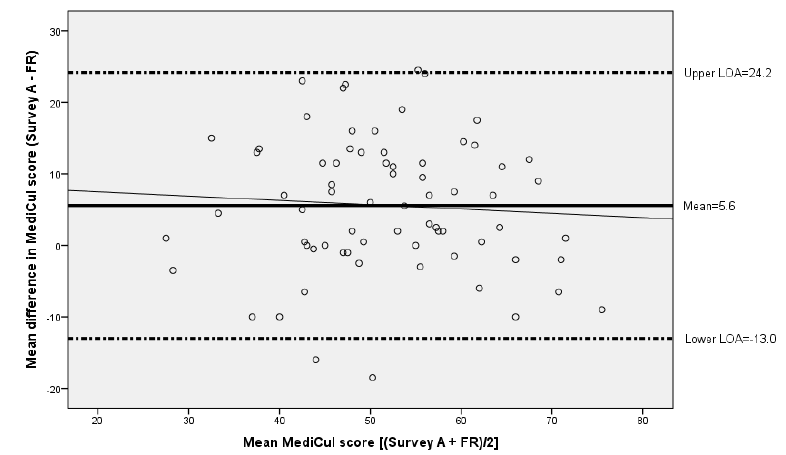
Figure 3. Bland-Altman plot of the difference in the Mediterranean Diet and Culinary Index (MediCul) score between survey A (first administration of MediCul tool) and three-day FR versus the mean MediCul score of the two methods ( n = 71). The solid line indicates the mean difference, whereas the dotted lines are the limits of agreement representing ± 2 SD from the mean difference within which 95% of the differences between the methods are expected to fall. The fitted regression line is ((y = 8.7 − 0.06*x) (95% CI: − 0.278, 0.158, p = 0.584)), and indicates no significant linear trend. Abbreviations: FR, food record.